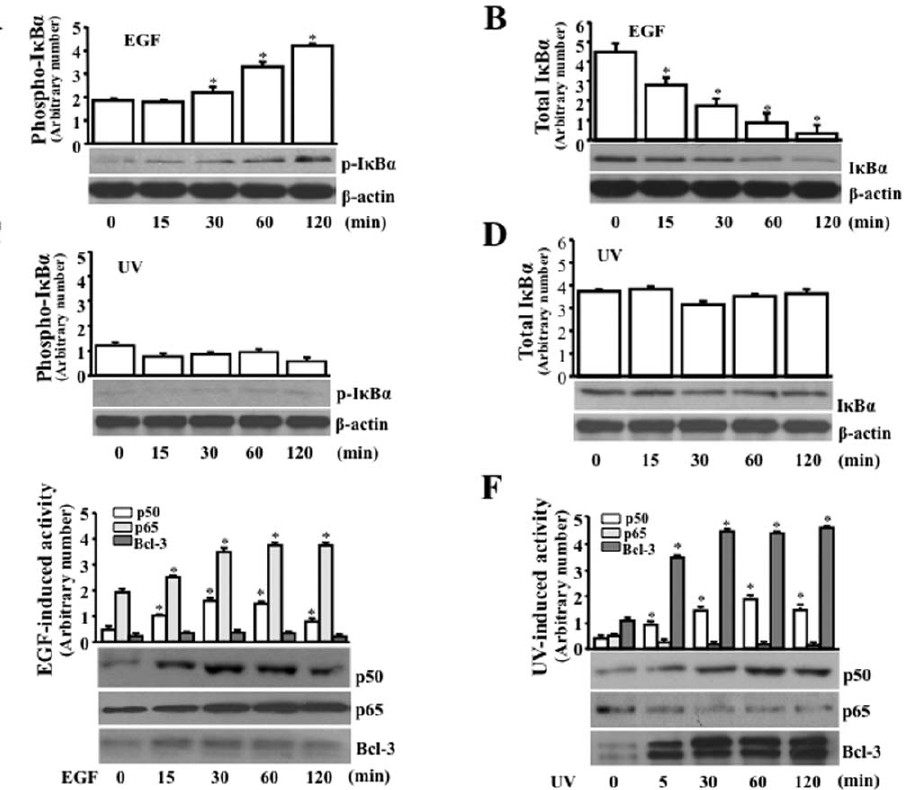
Figure 1. Effects of EGF- and UV stress-induced activation of NF- k B pathways. (A) Time course EGF-induced phosphorylation of I k B a . (B) Time course EGF-induced degradation of I k B a . (C) Effect of UV stress on phosphorylation of I k B a . (D) Effect of UV stress on degradation of I k B a . (E) Effect of EGF stimulation on nuclear activities of p50, p65 and Bcl-3. (F) UV stress-induced nuclear activities of p50, p65 and Bcl-3. HCE cells were synchronized by serum-depletion for 24 h. Total and nuclear proteins were extracted following stimulation at indicated time points and detected by Western analysis. Symbol ‘‘*’’ indicates significant differences between control and induced HCE cells ( p , 0.05, n=3).